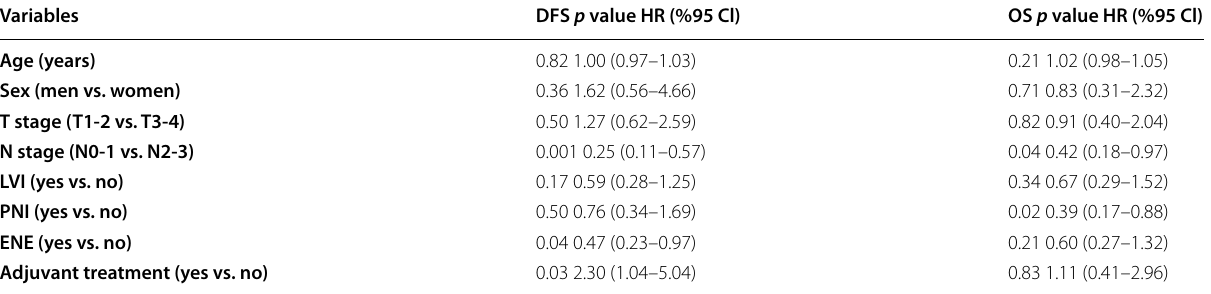
Table 3 Univariate analysis of different variables affecting DFS and OS